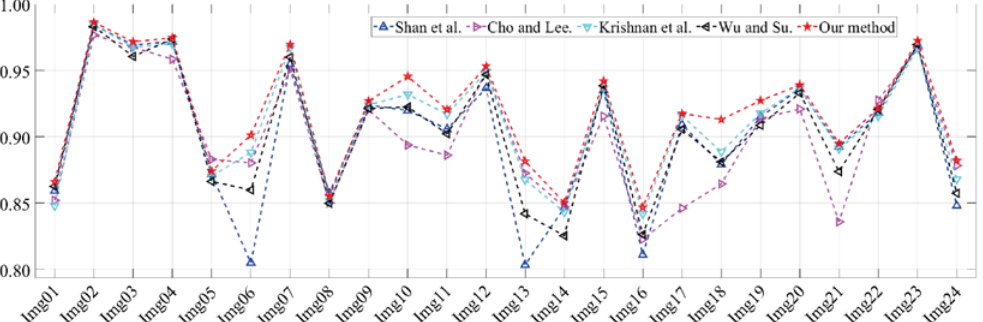
Figure 9. Statistics related to the average structural similarity indexes (SSIMs) for the comparison results of all the test images.